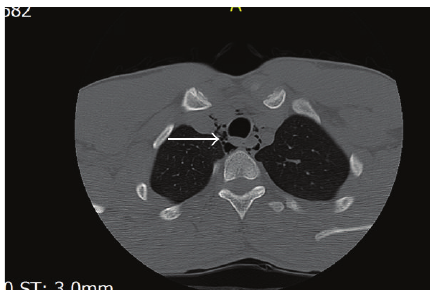
Figure 3: Mediastinal CT scan, axial section; free air is present around trachea and in mediastinum